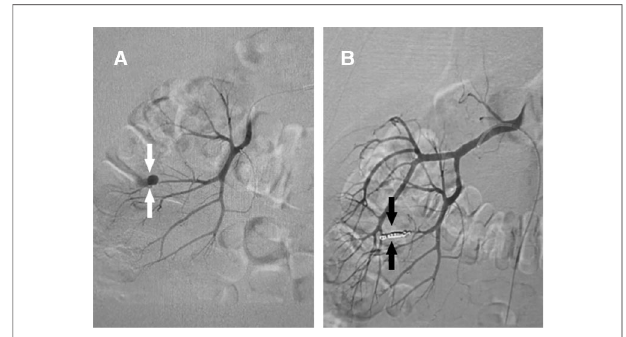
FIGURE 1 | ( A ) An angiogram showing a right interlobar RAP (white arrows). ( B ) Microcoils embolizing the pseudoaneurysm in the right kidney (dark